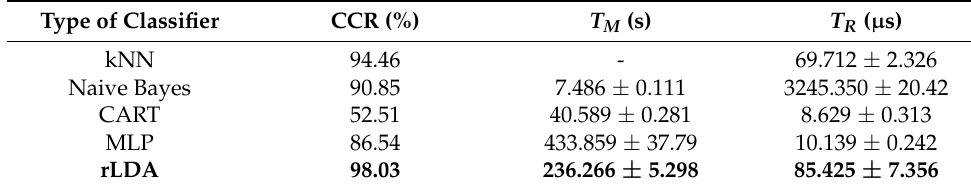
Table 3. Classification results for individual classifiers with Group 2